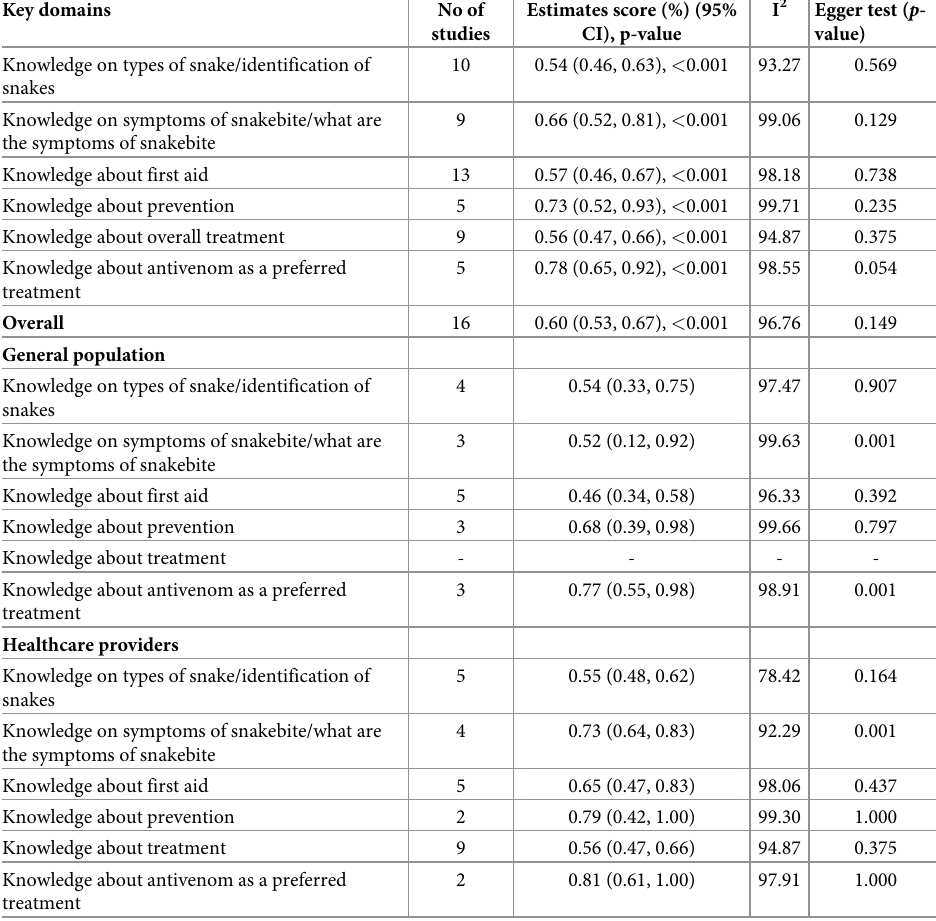
Estimates score (%) (95% studies CI), p-value